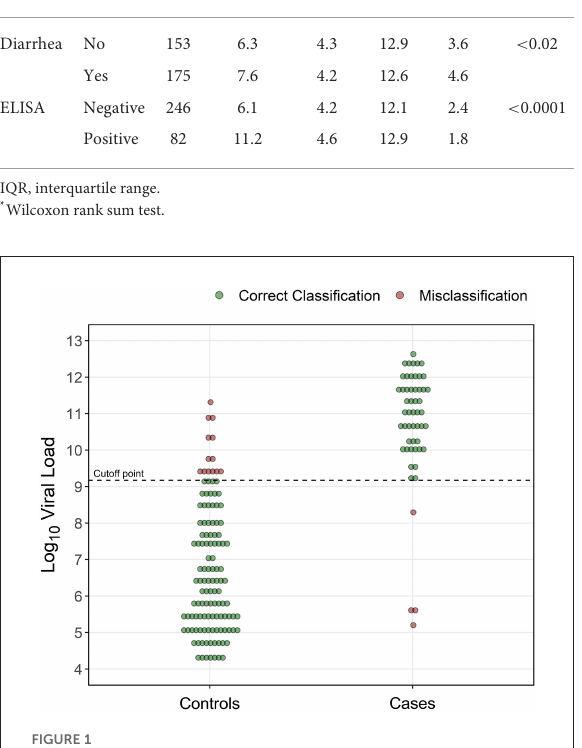
FIGURE1 Rotavirus A log10 viral load determined by RT-qPCR in fecal samples of 175 diarrheic calves that tested negative ( n = 122, controls) or positive ( n = 53, cases) by ELISA, and discrimination ability of the cutoff point (dotted line). Each sample represents a calf sample.